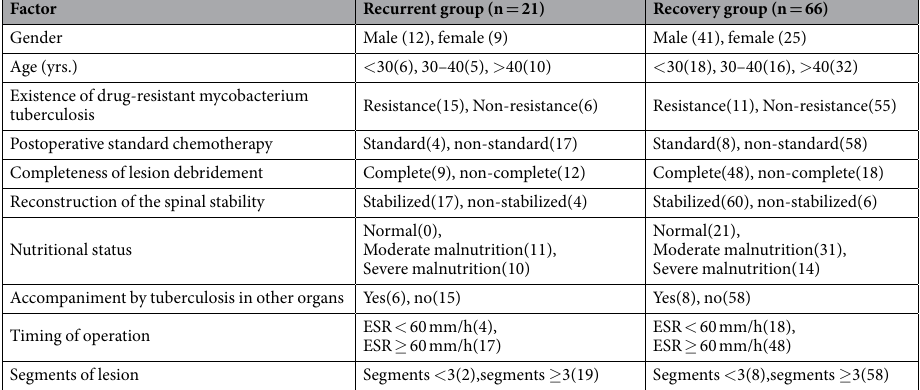
Table 2. The results of the quantization and valuation of the data in the recurrent and recovery